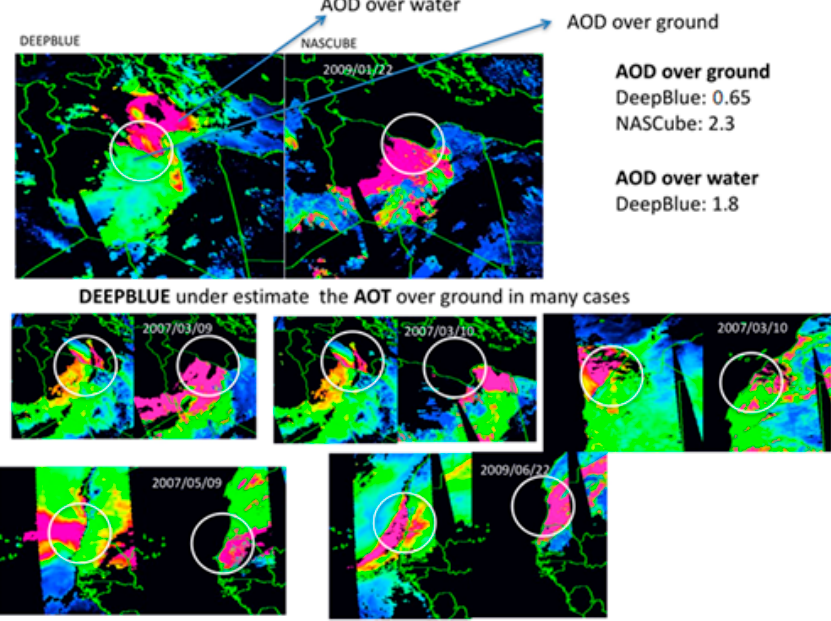
Figure 14. Overviews of Deep Blue (AQUA) (left inset) and NASCube (right inset) AOD values. NASCube only predicts AOD values over land. The various snapshots illustrate that Deep Blue AOD values are not continuous across land and ocean. On the other hand, the ocean Deep Blue results are close to the NASCube land ones.